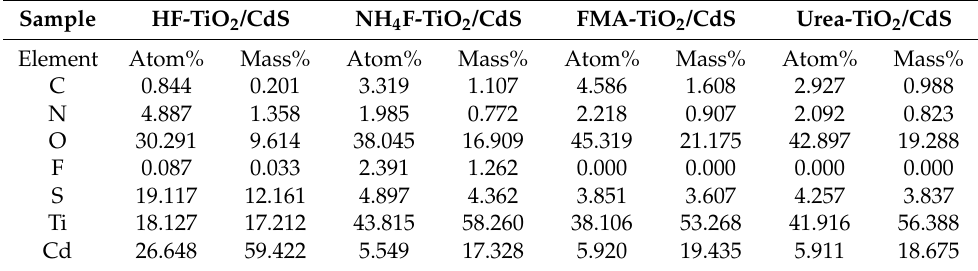
Table 2. EDX analysis of different TiO 2 /CdS